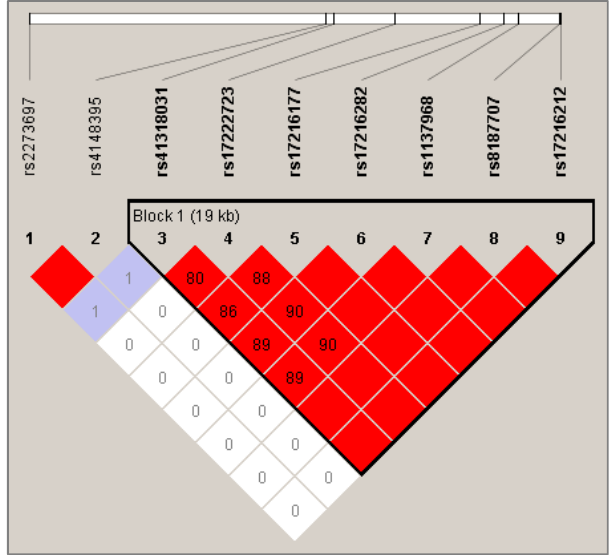
Figure 1. Linkage disequilibrium map of ABCC2 SNPs. The color of the lozenge represents the |D’| parameter and is filled with R2 value. The redder the lozenge and higher the value, the stronger the linkage between two SNPs. Absence of R2 value within the lozenge means R2 = 100% = complete linkage disequilibrium